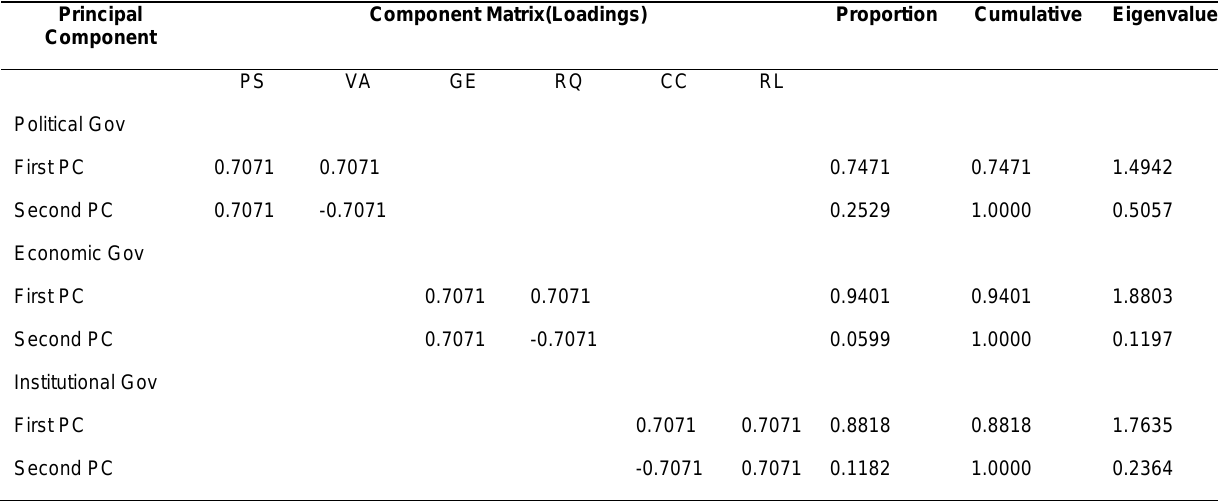
Table 3.3. Principal Component Analysis of Governance